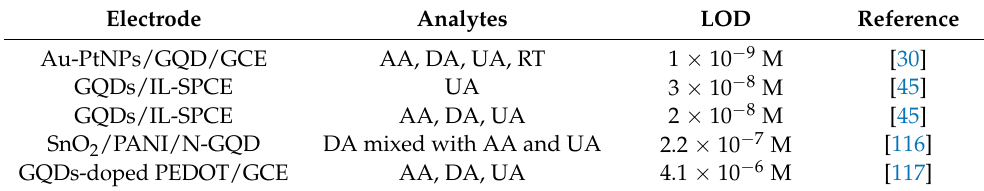
potential of anodic oxidation at 0.5 V, 0.3 V, 0.1 V, and 1 V. Table 4. LOD of sensors based on GQDs used for the UA detection. Table 4. LOD of sensors based on GQDs used for the UA detection. Electrode Analytes Electrode Analytes LOD